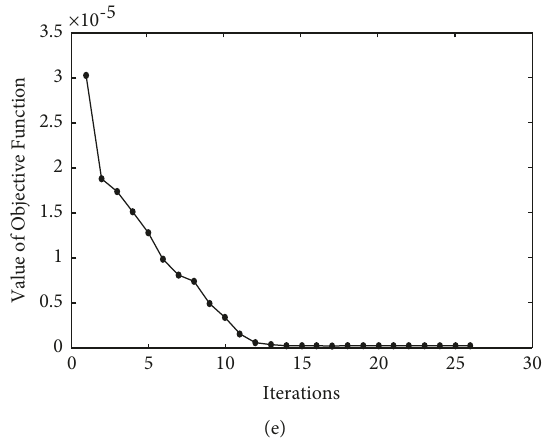
Figure 11: Convergence curves of each parameter and objective function: (a) Convergence curve of the elastic modulus of the aluminum alloy; (b) Convergence curve of the expansion coefficient of the aluminum alloy; (c) Convergence curve of the elastic modulus of the titanium alloy; (d) Convergence curve of the expansion coefficient of the aluminum alloy; (e) Convergence curve of the objective